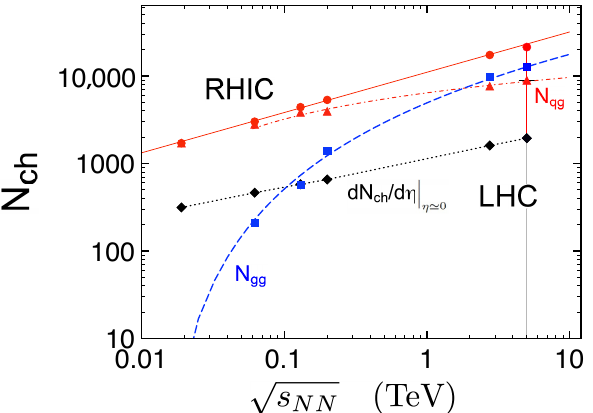
Figure 9. The total charged-hadron production in central Au-Au and Pb-Pb collision in the energy region 19.6 GeV to 5.02 TeV is following a power law (solid upper line), whereas the particle content in the fragmentation sources is N qg ∝ ln ( s NN / s 0 ) , dash-dotted curve. The particle content in the mid-rapidity source obeys N gg ∝ ln 3 ( s NN / s 0 ) , dashed curve. The energy dependence of the measured mid-rapidity yields is shown as a dotted line, with PHOBOS data [54] at RHIC energies, and ALICE data [57,62] at 2.76 and 5.02 TeV. The vertical line indicates 5.02